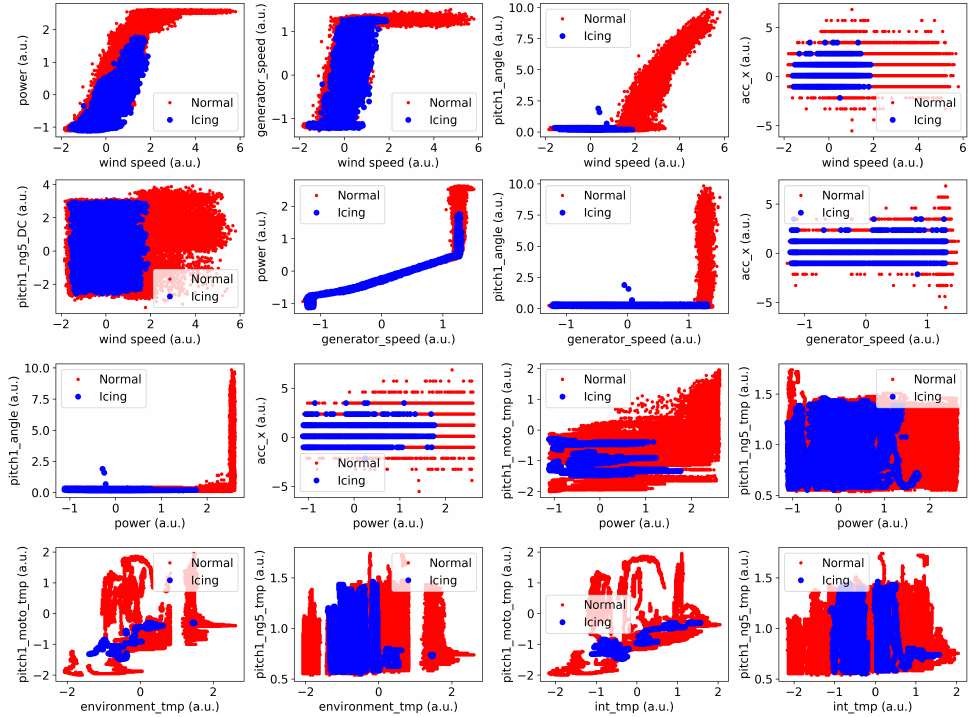
Figure 5. Pair plot for several representative variables under normal and icing conditions, where all sensor variables are